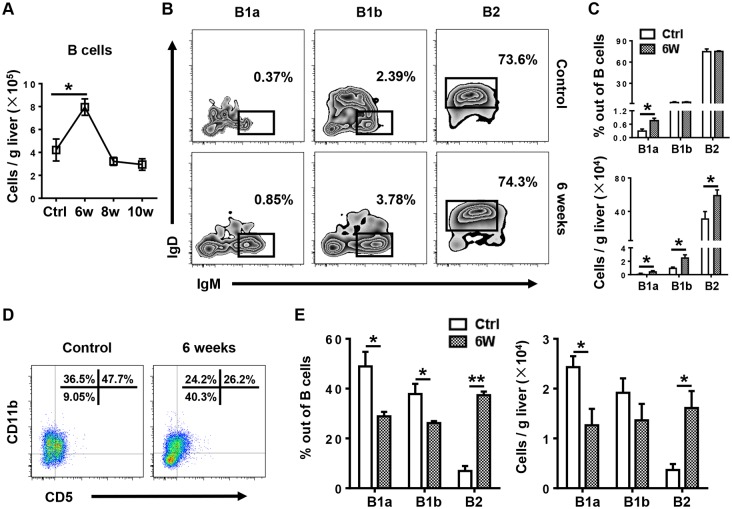
Hepatic B1 cells increase whereas PC B1 cells decrease after S. japonicum infection.(A) Number of B cells (CD3−CD19+) in WT mice at the times indicated after infection. (B) Representative flow cytometry plots of hepatic B1a (CD3−CD19+CD5+CD23−IgMhiIgDlo), B1b (CD3−CD19+CD5−CD23−IgMhiIgDlo), and B2 (CD3−CD19+CD5−CD23+IgMloIgDhi) cells in WT mice 6 weeks after infection. (C) Graphical summary showing the percentages of B1a, B1b, and B2 cells out of total B cells (top panel) and the number of indicated subsets (bottom panel) in the livers of WT mice without infection (Ctrl) and 6 weeks after infection. (D) Representative flow cytometry plots of PC B1a (CD3−CD19+CD5+CD11b+), B1b (CD3−CD19+CD5− CD11b+), and B2 cells (CD3−CD19+ CD5−CD11b−) in WT mice without infection and 6 weeks after infection. (E) The percentages of B1a, B1b, and B2 cells out of total B cells (left panel) and number of indicated subsets (right panel) in the PC of WT mice without infection and 6 weeks after infection. Data represent mean ± SD; n = 8–10 mice per group from two independent experiments. *p < 0.05, **p < 0.01.